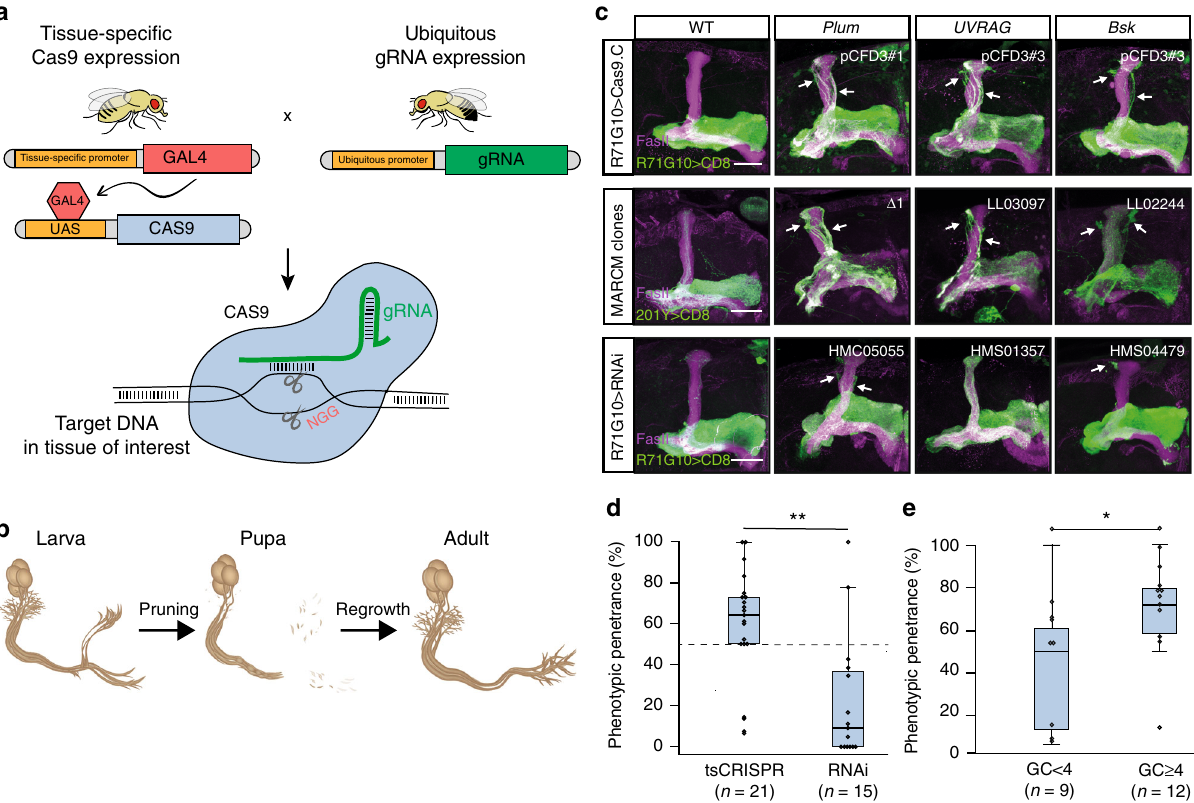
Fig. 1 tsCRISPR is ef fi cient in the fl y central nervous system. a Schematic representation of tsCRISPR using the GAL4/UAS system. b Scheme of MB γ neuronal remodeling throughout metamorphosis. (Adapted from ref. 24 ). c Confocal Z-projections of adult MBs expressing the indicated gRNAs as well as UAS-Cas9.C and membrane bound CD8::GFP (CD8) driven by R71G10-GAL4 (upper row); or MB neuroblast MARCM clones of the indicated alleles labeled by CD8 driven by 201Y-GAL4 (middle row); or MBs expressing the indicated TRiP RNAi ’ s and CD8 driven by R71G10-GAL4 (lower row). While R71G10-